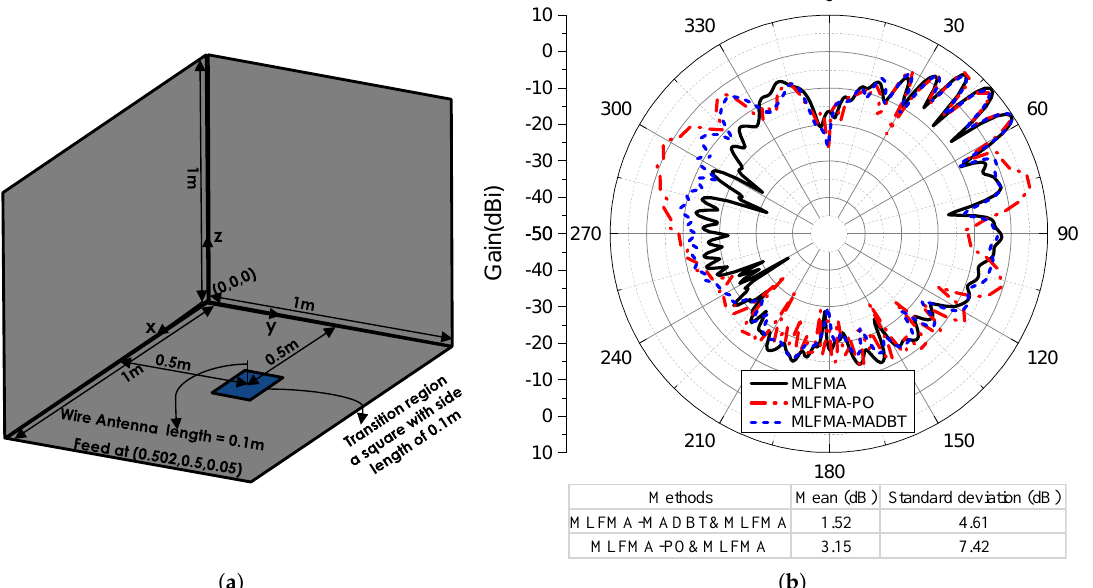
Figure 10. The model and far-field radiation patterns in XOZ plane of the wire antenna mounted on a trihedral corner reflectors. ( a ) Model ( b ) Comparison result.